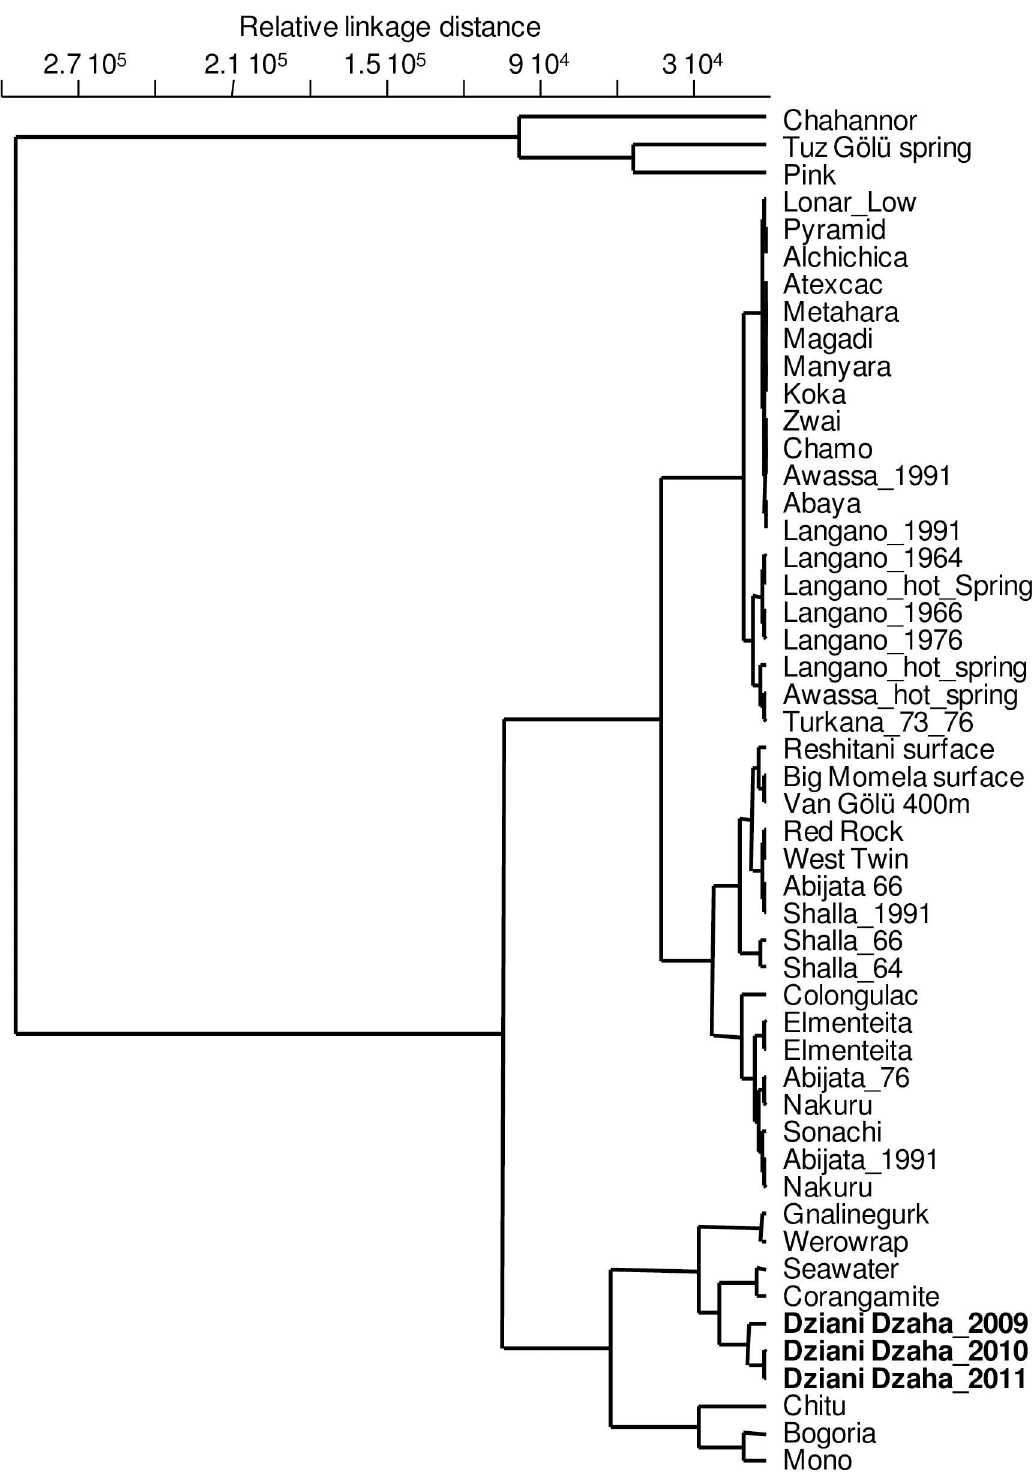
Fig 3. Hierarchical clustering of 50 saline lake waters. Ward’s method clustering basedon the records of the six major dissolvedelements(Na + , K + , Mg 2+ , Ca 2+ , SO 42- , Cl - ) expressedas mg L -1 , and total alkalinityexpressedas mg L -1 eq.CO 32-